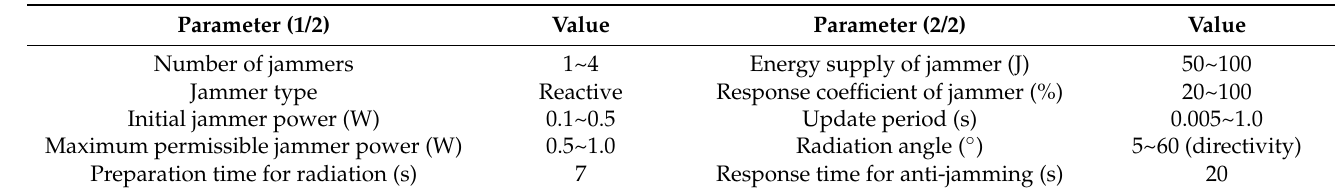
Table 2. D-CEWS (DEVS-based cyber-electronic warfare)-based communication and functional simula- tion parameters for multi-layered jamming and related anti-jamming with electronic warfare threat.